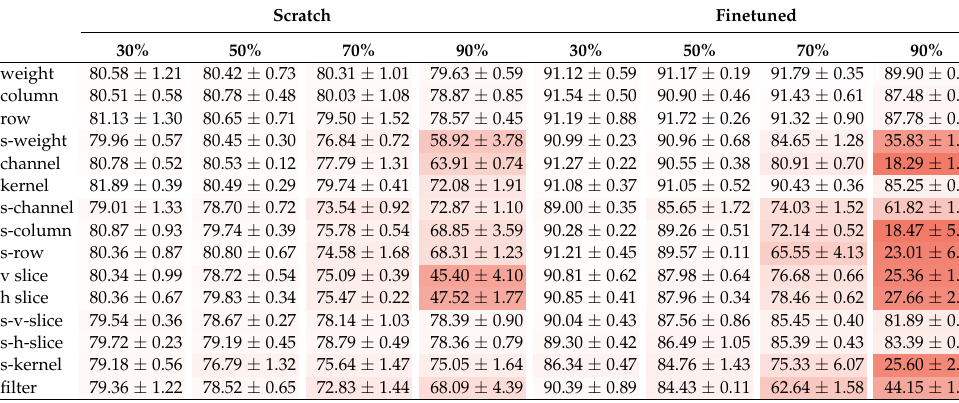
Table 2. Results of sparsifying ResNet-18 for all available granularities. Context, criteria and schedule are respectively set to global, large_final and one_cycle. Mean and standard deviation of accuracy over 3 rounds are reported. The darker the shade of red, the further the accuracy is from the baseline. Scratch Finetuned 30% 50% 70% 90% 30% 50% 70% 90%